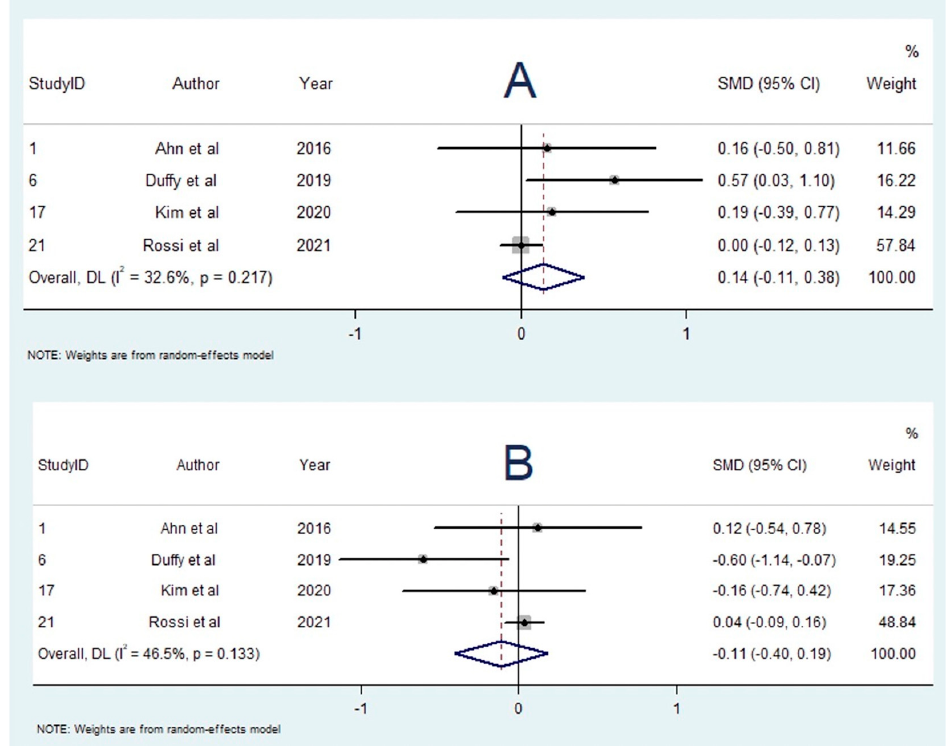
Figure 8. Forest Plots of Meta-analyses on clot composition and bridging thrombolysis. ( A ): RBC content and bridging thrombolysis. ( B ) Fibrin content and bridging thrombolysis. Abbreviations: DL: DerSimonian and Laird method, SMD: Standarized Mean Difference, CI: Confidence Interval, RBC: Red Blood Cell.